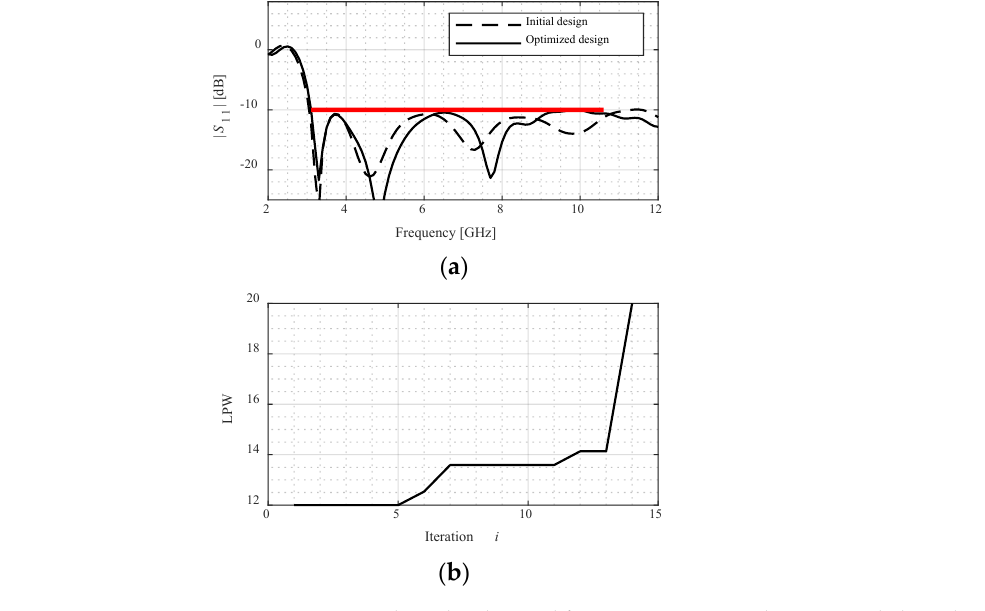
Figure 7. Numerical results obtained for Antenna I using the proposed algorithm incorporating multi-fidelity model management and adaptive penalty coefficients: ( a ) reflection responses, ( b ) evolution of the model fidelity. The horizontal line represents the design specifications.